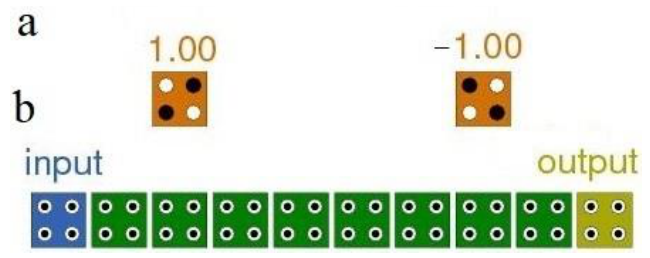
Figure 1. ( a ) QCA cell and ( b ) wire.